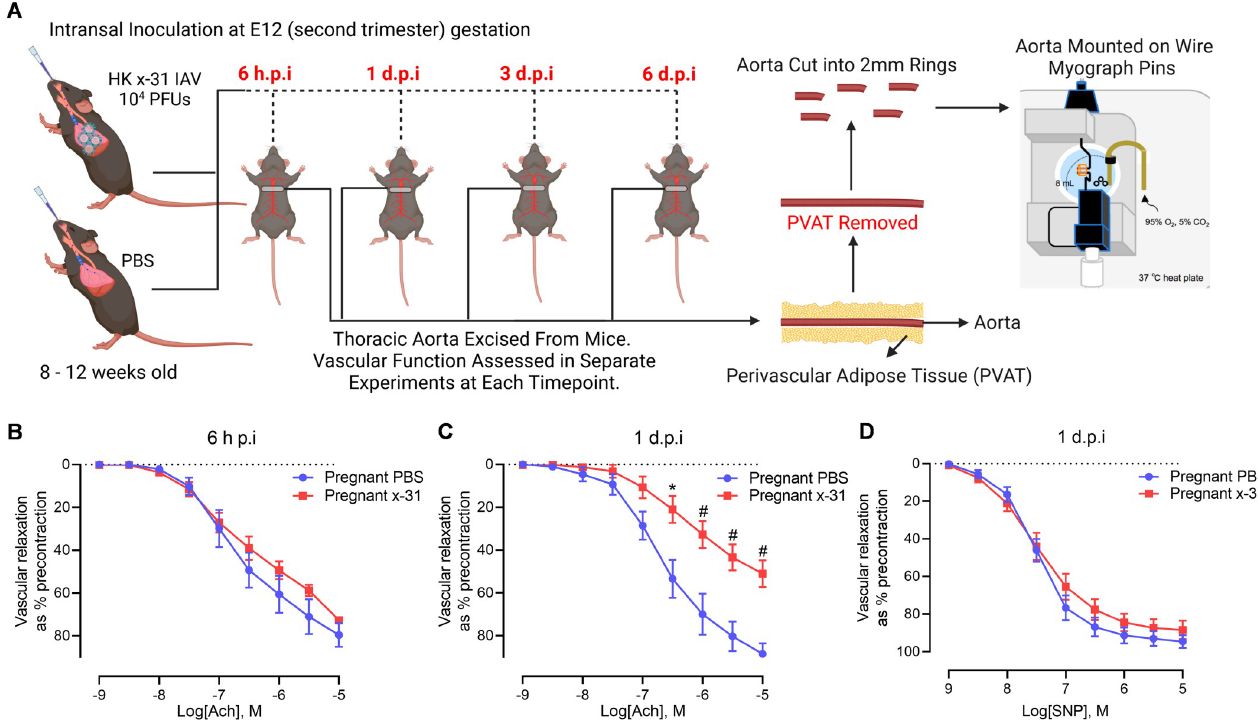
Fig 2. IAV infection triggers early onset endothelial dysfunction in pregnant mice. Vascular function was assessed at 6 h and 1 d.p.i in isolated thoracic aortic rings of pregnant mice inoculated with PBS or Hk-x31 (X-31; 10 4 PFU). (A) Schematic of infection schedule and experiments (created with BioRender. com) (B) Endothelium-dependent vasodilation to acetylcholine (ACh) at 6 h.p.i. (C) 1 d.p.i vascular function assessment to endothelium-dependent vasodilator —ACh. (D) 1 d.p.i vascular reactivity assessment to endothelium independent vasodilator–SNP. Vascular relaxation is calculated as a % of pre-constriction to U-46619 (thromboxane agonist). Data are represented as mean ± SEM (pregnant PBS, n = 4–8; pregnant X-31, n = 4–8 of at least two independent experiments). Statistical analysis was conducted using a two-way analysis of variance (ANOVA) followed by Holm’s Sidak post-hoc multiple comparison. � P < 0.01, # P <